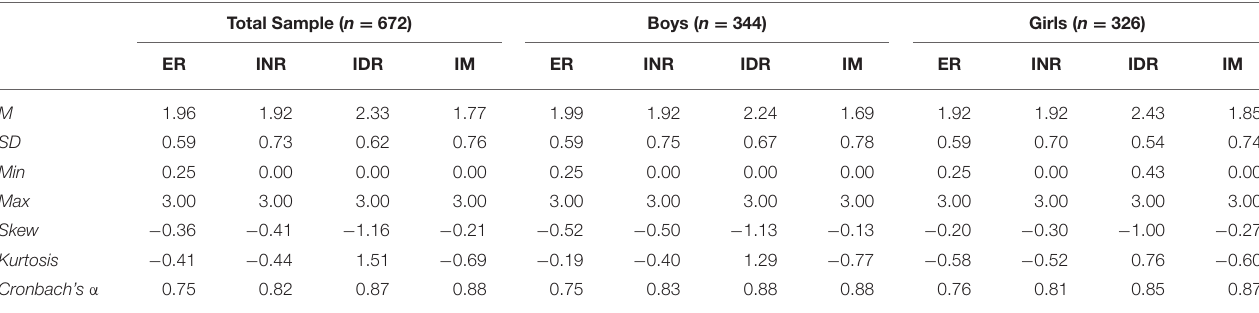
TABLE 2 | Summary of preliminary analysis by